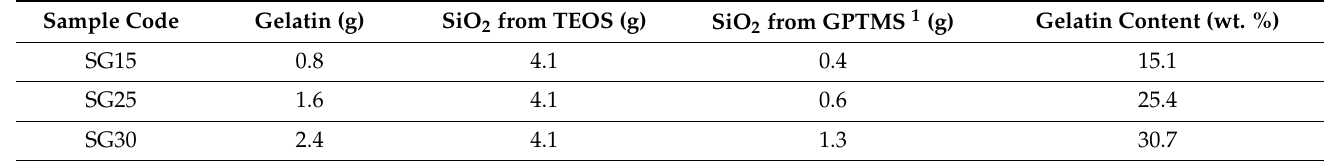
Table 1. Nominal compositions of the prepared hybrid aerogel materials.